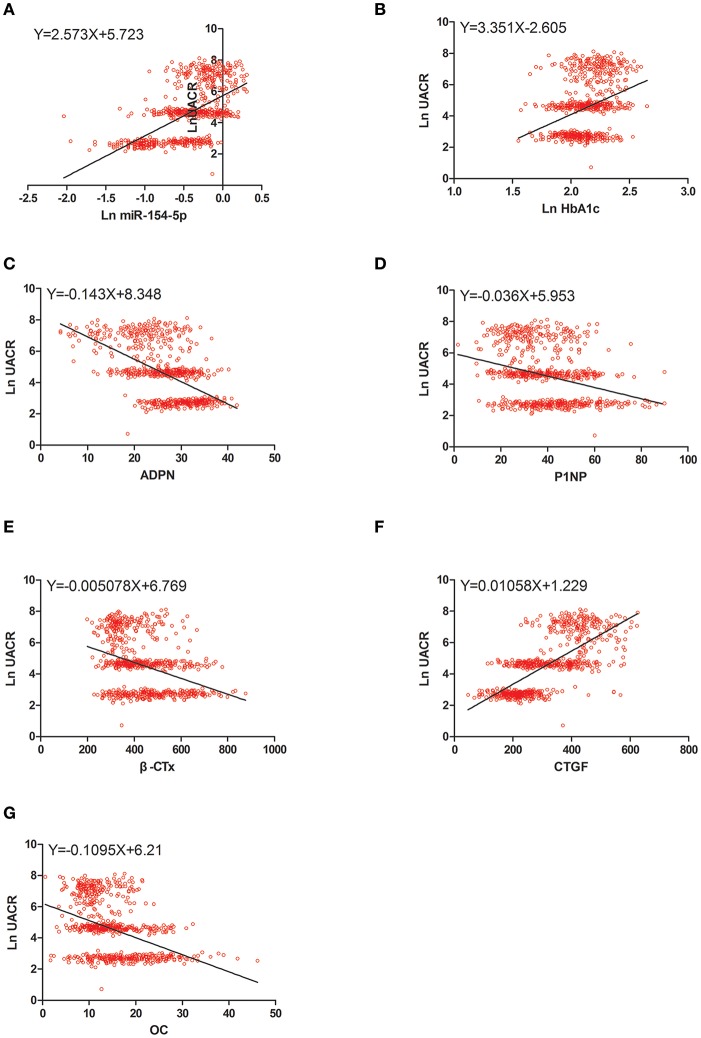
Scatter dot plots between Ln UACR and (A) Ln miR-154-5p, (B) Ln HbA1c, (C) ADPN, (D) P1NP, (E) β-CTx, (F) CTGF, (G) OC. UACR, urinary albumin excretion rate; HbA1c, glycated hemoglobin A1c; ADPN, adiponectin; P1NP, procollagen type 1 N-terminal propeptide; β-CTx, β-C-terminal telopeptide of type I collagen; CTGF, connective tissue growth factor; OC, osteocalcin.